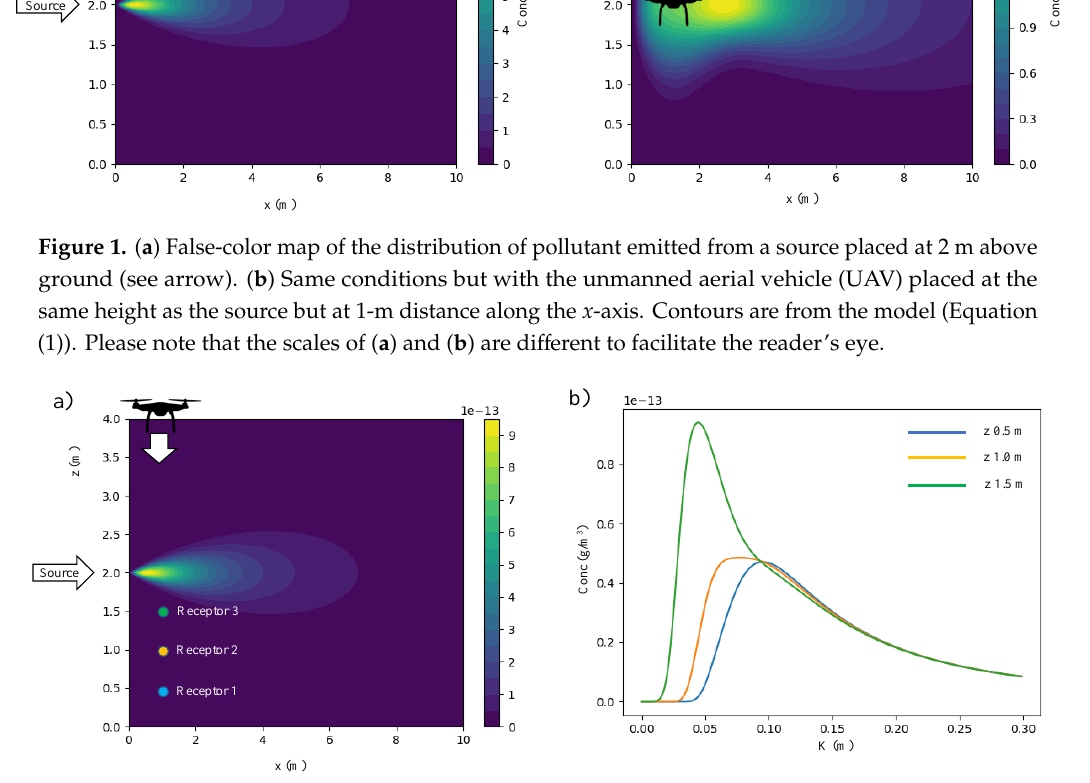
Figure 2. ( a ) Schematic representation of the simulated scenery. ( b ) Calculated pollutant concentration detected at the receptors as a function of K parameter representing the amount of turbulence induced by the propellers.